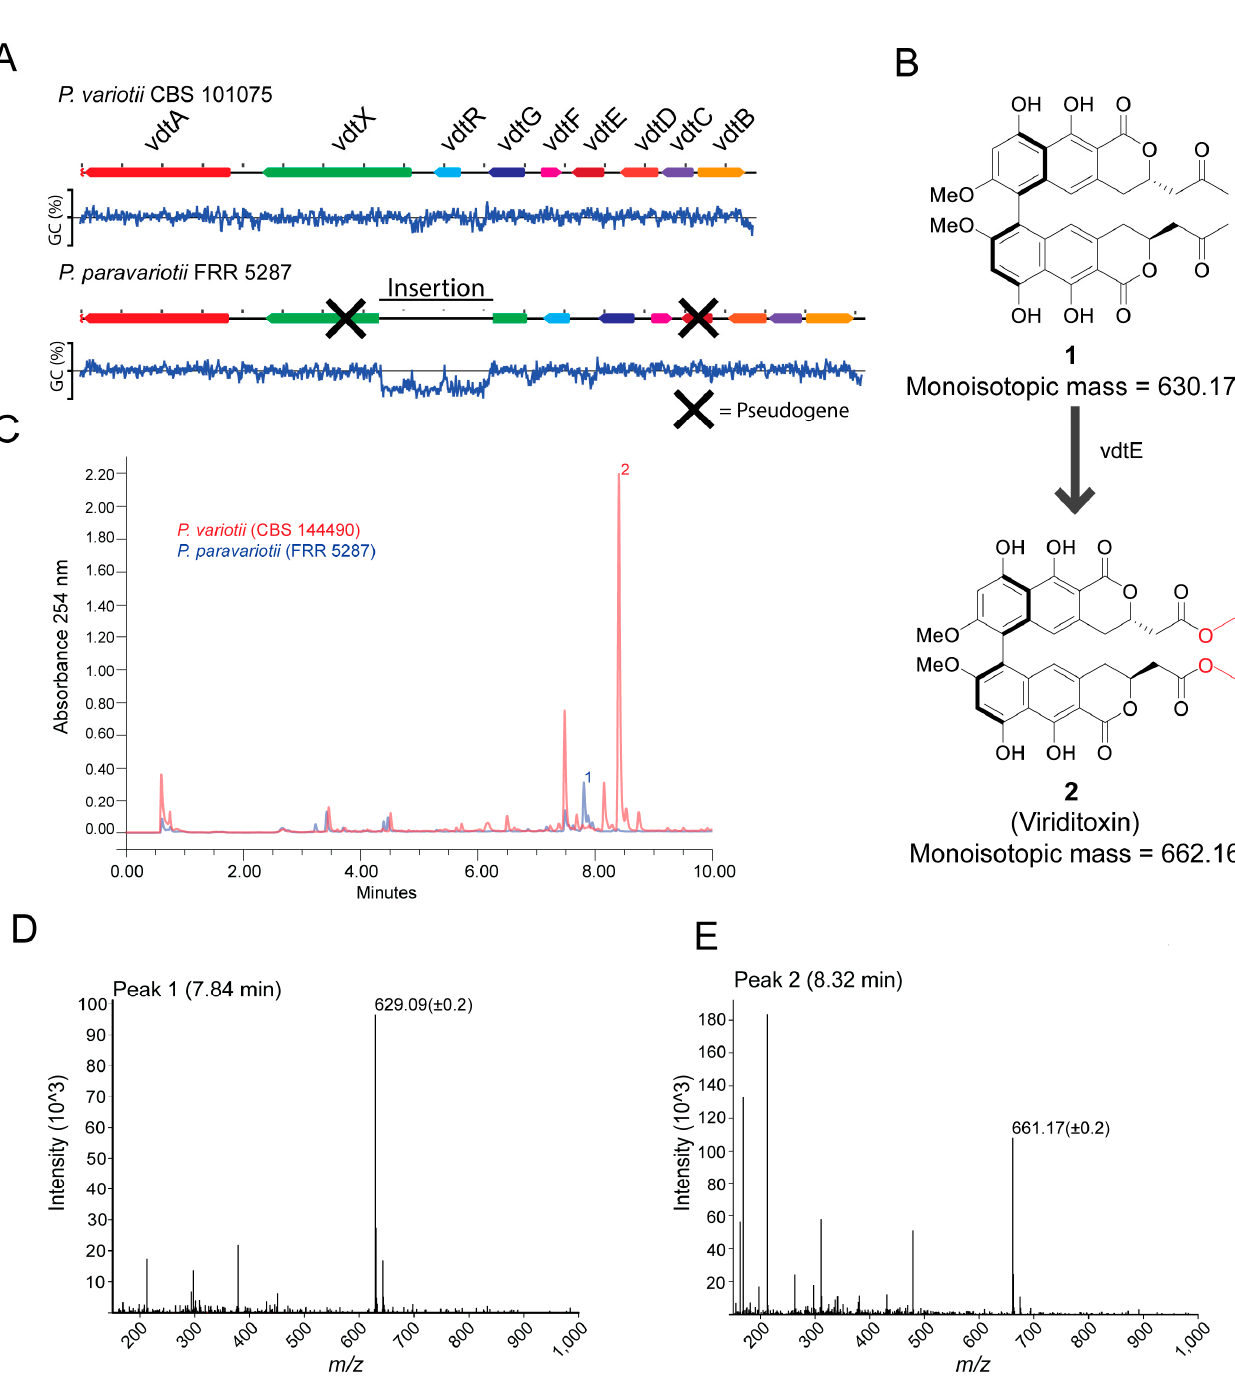
viriditoxin (Figure 4B) [19]. A vdtE deletion mutant of P. variotii thus produces compound 1 in place of viriditoxin (Figure 4B; [19]).